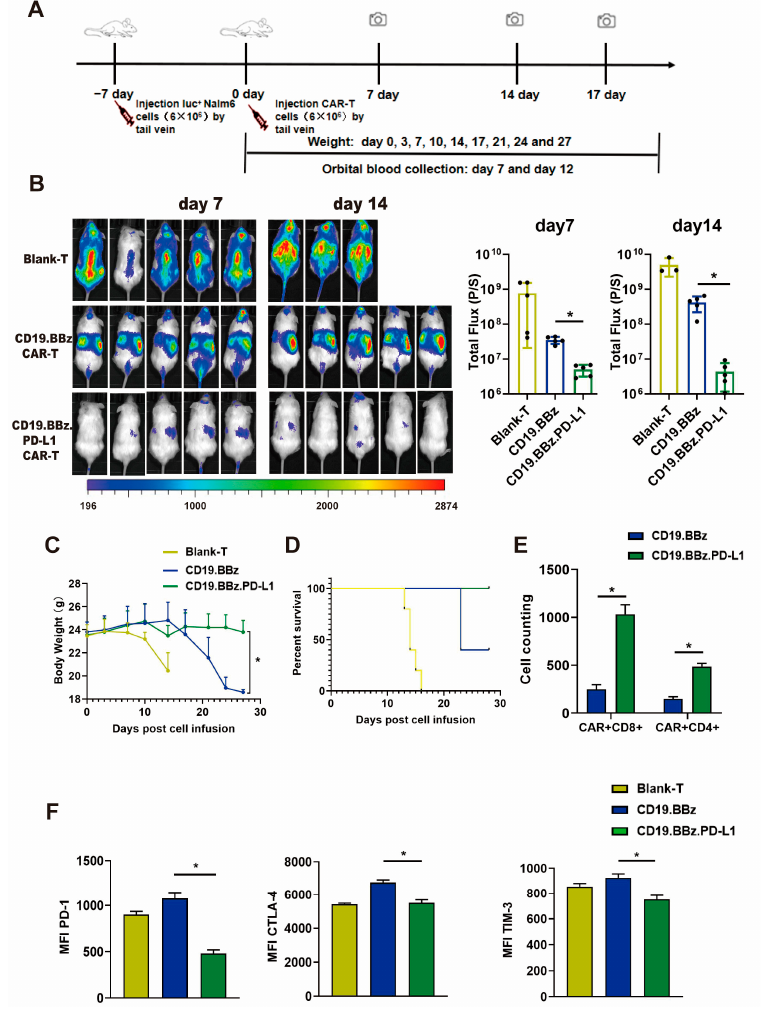
Figure 5. Anti-tumor effect of blank T, CD19.BBz CAR T and CD19.BBz.PD-L1 CAR T cells against Nalm6-Luc xenograft tumors. ( A ) Scheme of the experimental procedure. ( B ) Tumor burden was analyzed by bioluminescent imaging at day 7 and 14 (scattered plot, n = 5). ( C ) Mouse weight curves ( n = 5). ( D ) Kaplan–Meier curve of survival. ( E ) T cells were isolated from 0.5 mL blood by CD3 microbeads and the number the CAR T cells was counted and the amount of CD4 + and CD8 + cells was analyzed by flow cytometry ( n = 3). ( F ) The expression of the T cell surface markers PD-1, CTLA-4, and TIM-3 was measured by flow cytometry, and MFI was calculated using FlowJo ( n = 3). A total of three healthy donors were enrolled in in vivo experiments and the mice experiment was performed once for each donor. We present data from a representative individual. One-way ANOVA analysis was performed to determine statistical significance, the results are means ± SD. (* p < 0.05, compared with CD19.BBz CAR T cells group).